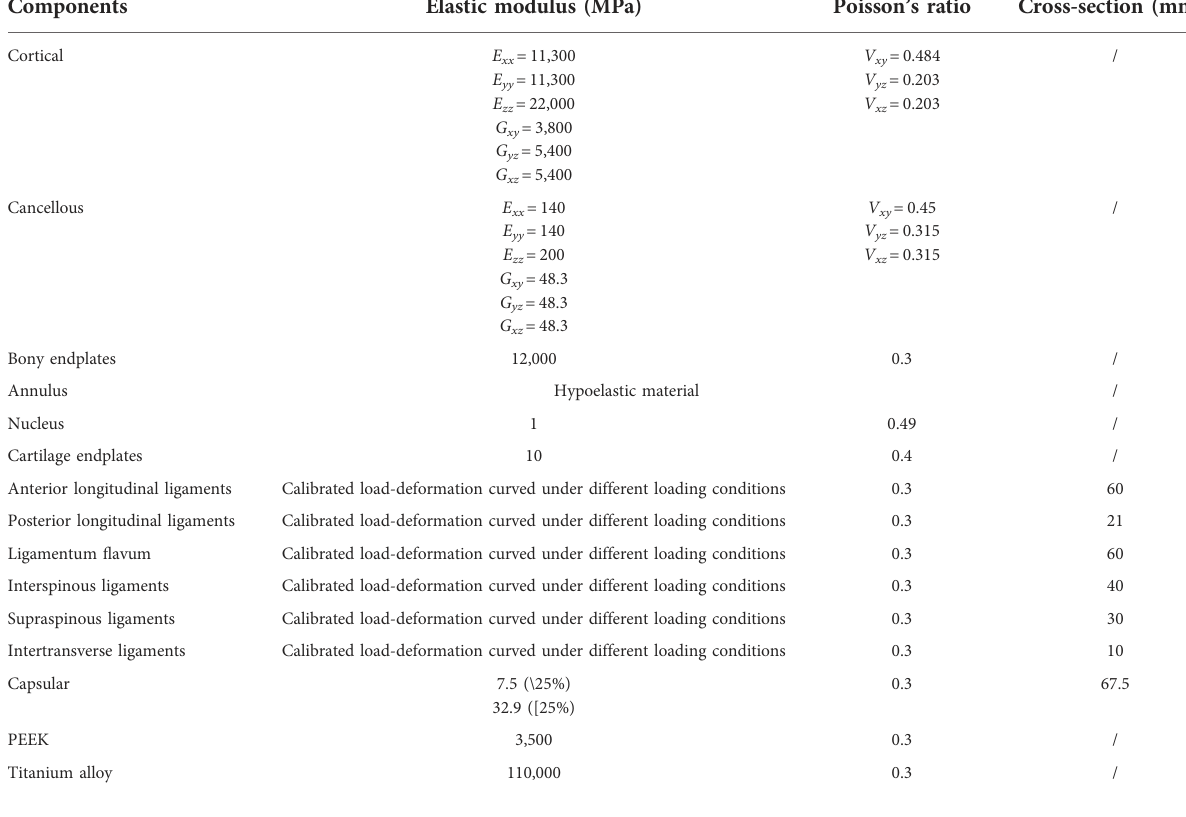
TABLE 1 Material properties of components in current models.